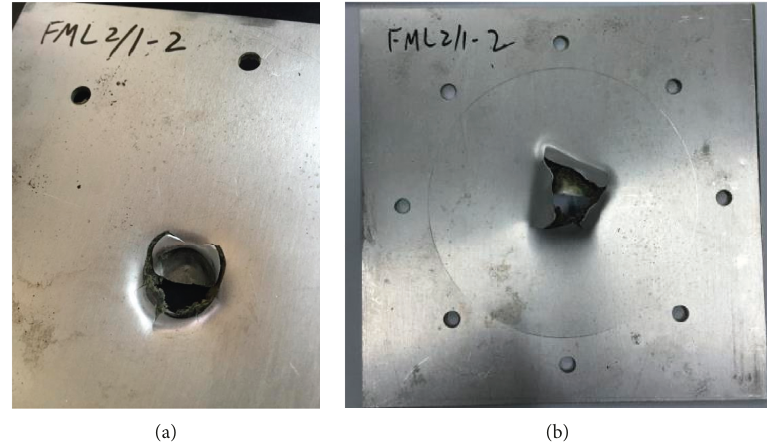
Figure 13: Failure modes of the BFML plate: (a) impacted face; (b) nonimpacted face.